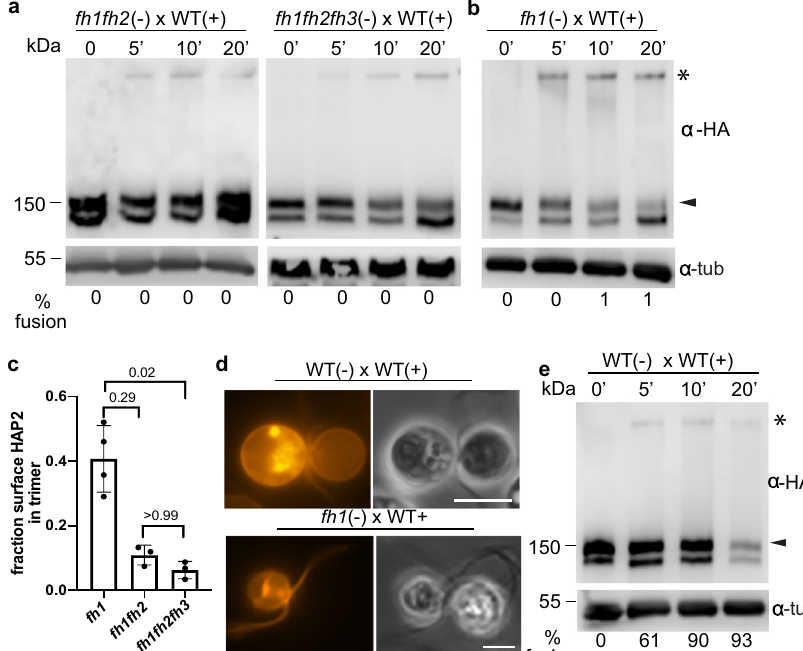
Fig. 5 Fusion helix membrane interaction made possible by mating structure attachment promotes trimer formation and trimer formation ceases when adhesion ceases. a , b Semi-native SDS-PAGE immunoblots showing HAP2 trimer formation in fusion helix mutant minus gametes after mixing with plus gametes for the times indicated. c The fraction of surface HAP2 forming trimers was strongly reduced in fh1fh2 and fh1fh2fh3 compared to fh1 gametes after mixing with WT plus gametes. Signal intensities of the trimer band and the upper monomer band at 5 min time points from at least three independent experiments were quanti fi ed by Image Studio Lite (LI-COR Biosciences). The Kruskal-Wallis test and Dunn ’ s post-test were utilized to analyze the statistical differences among mutants. P-values are indicated above the corresponding columns. d fh1 minus gametes mixed with WT plus gametes failed to undergo hemifusion. WT plus gametes were incubated with membrane dye PKH26, washed into N-free medium, and mixed with the indicated minus gamete mutants for at least 20 min. Left panels are fl uorescence images and right panels are phase-contrast images. At least 200 pairs of cells were observed with similar results. Scale bars, 5 μ m. e Semi-native SDS-PAGE immunoblot showing HAP2 trimer formation in WT minus gametes after mixing with WT plus gametes for the indicated times. % fusion is shown under the lanes. The blot images in a , b , and e are representative of at least 3 independent experiments.